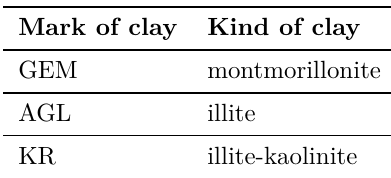
Table 1. Three basic kinds of clay.